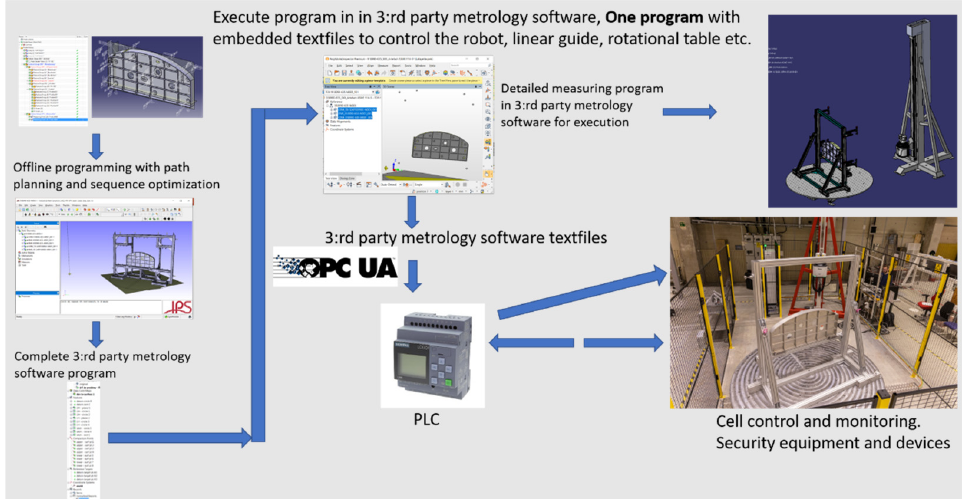
20 Figure 21. Principal construction of the laser radar measuring cell. The data and information process acting in this measuring cell is described in Figure 22, which shows the different steps and how the system is communicating on a high level. 1.